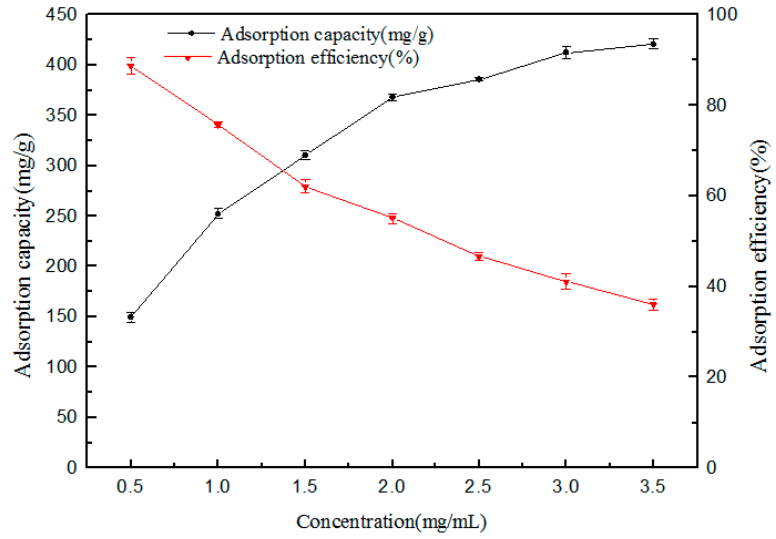
Figure 10. Effect of the initial concentration on the extraction efficiency. Figure 10. E ff ect of the initial concentration on the extraction e ffi